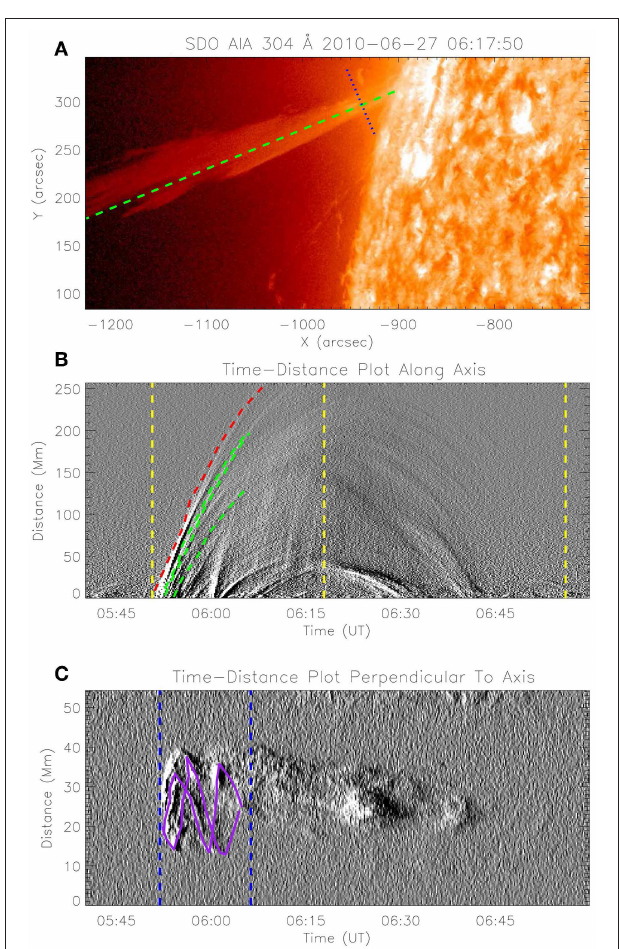
FIGURE 3 | (A) similar to Figure 2A , but for another off-limb coronal jet event on 27 th June 2010 at 06:18 UT. (B) is a running difference time-distance plot along the jet axis. Again, three yellow vertical dashed lines represent the starting, peak and ending time of the jet, respectively. The red dashed curve denotes the parabolic fitting of the outermost sub-jet. Green dashed curves (together with the red dashed curve) indicate trajectories of sample sub-jets used to estimate the average projected axial speed of the jet during the period of its rotational motion. (C) is a running difference time-distance plot perpendicular to the jet axis. Two blue vertical dashed lines denote the estimated starting and ending time of the rotational motion, respectively. Purple solid curves are sinusoidal fittings of corresponding sinusoidal-like trajectories. These sinusoidal features are evidence of the rotational motion instead of the kink motion (see main